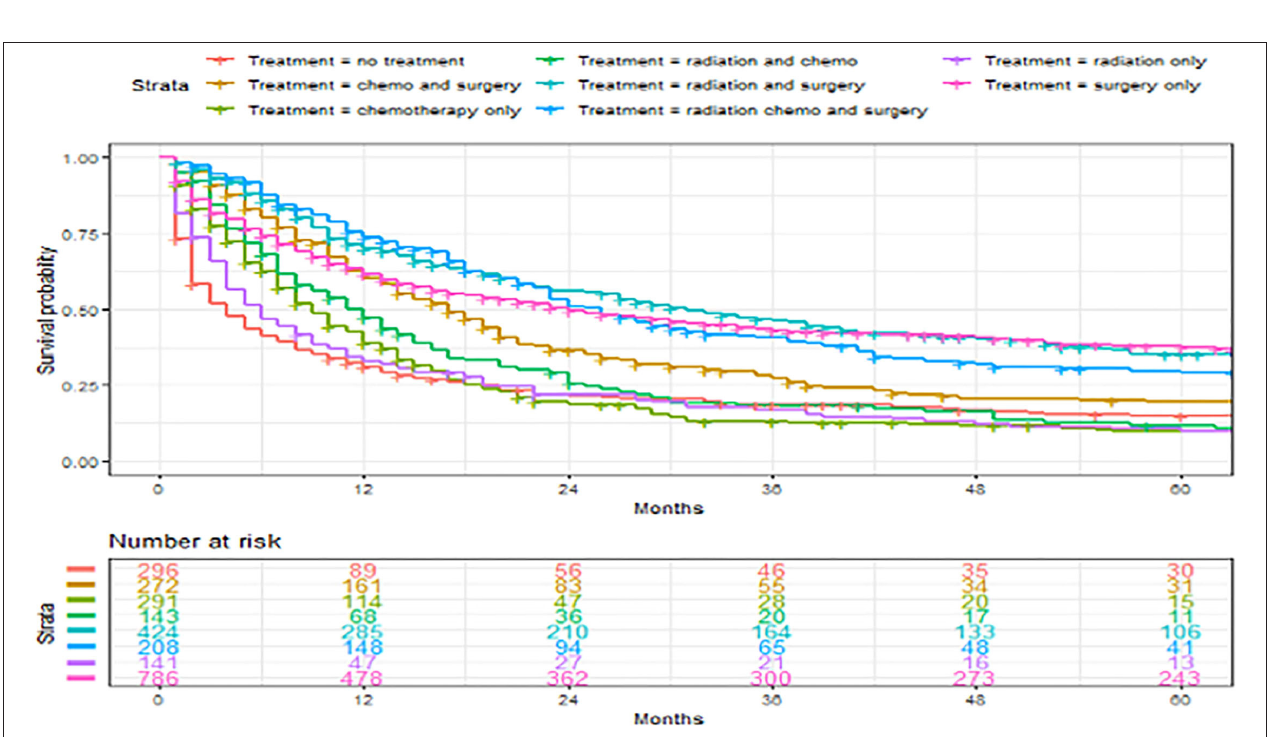
FIGURE 6 | Overall survival of patients with angiosarcoma stratified by treatment. Survival was calculated using the Kaplan-Meier methods.